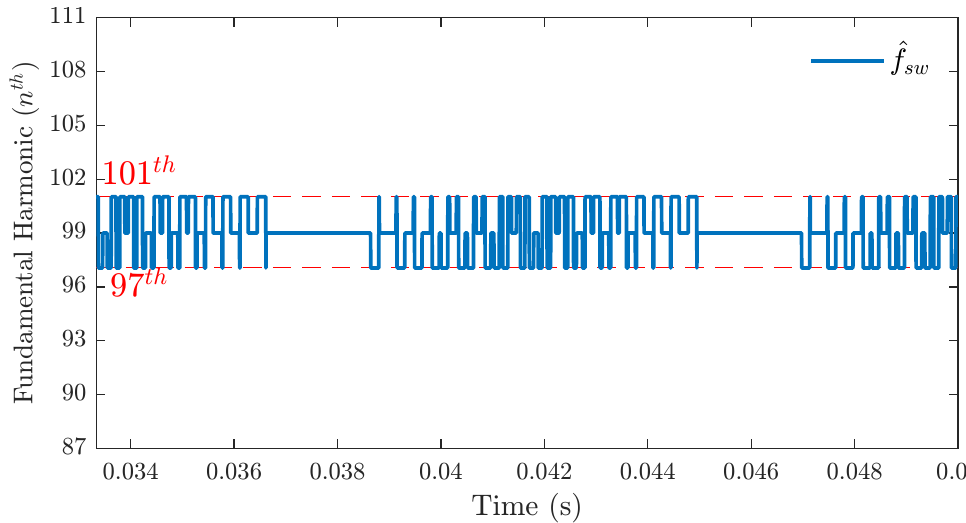
Figure 2. Instantaneous switching frequency of an ideal PWM modulator using Algorithm 1.